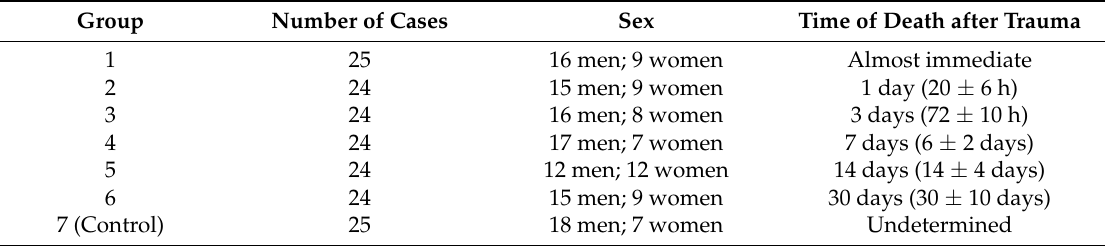
Table 3. Study population divided according to the survival interval after traumatic brain injury (TBI).